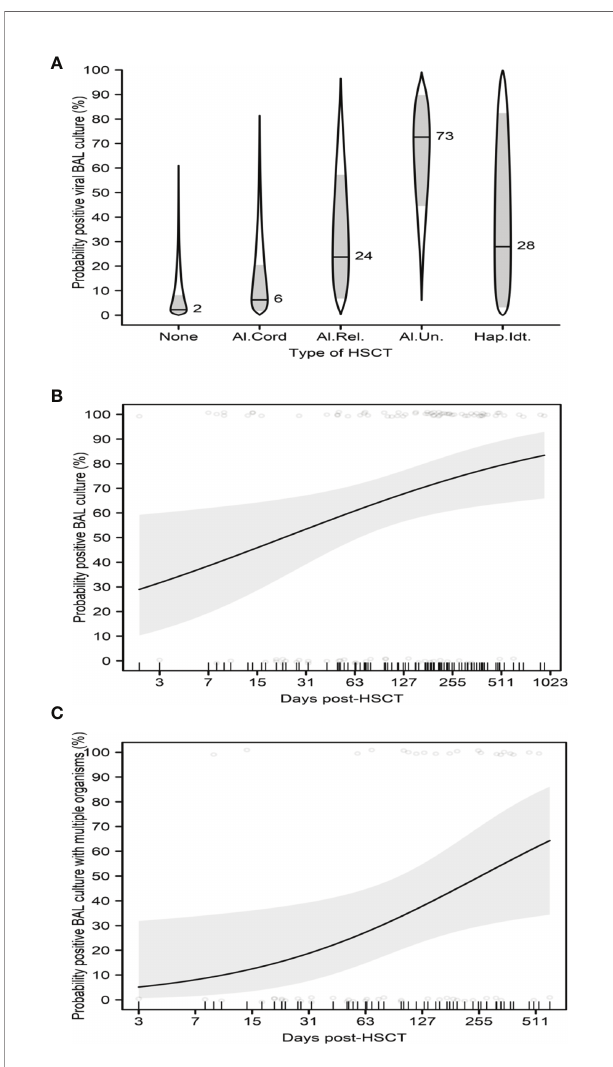
FIGURE 5 | Impact of HSCT on BAL. (A) Probability of positive viral BAL culture with type of HSCT. (B) Probability of positive BAL culture with post- HSCT duration. (C) Probability of positive BAL culture with multiple organisms with post-HSCT duration. (A) shows catseye plots illustrate the normal distributions of the model-adjusted means (horizontal lines, with corresponding numeric percentage probability), with shaded +/- standard error intervals, transformed to the probability scale. In (B, C) , regression curves are shown as solid lines, bounded by shaded 95% con fi dence intervals. Scatterplots show raw patient measures, jittered slightly for